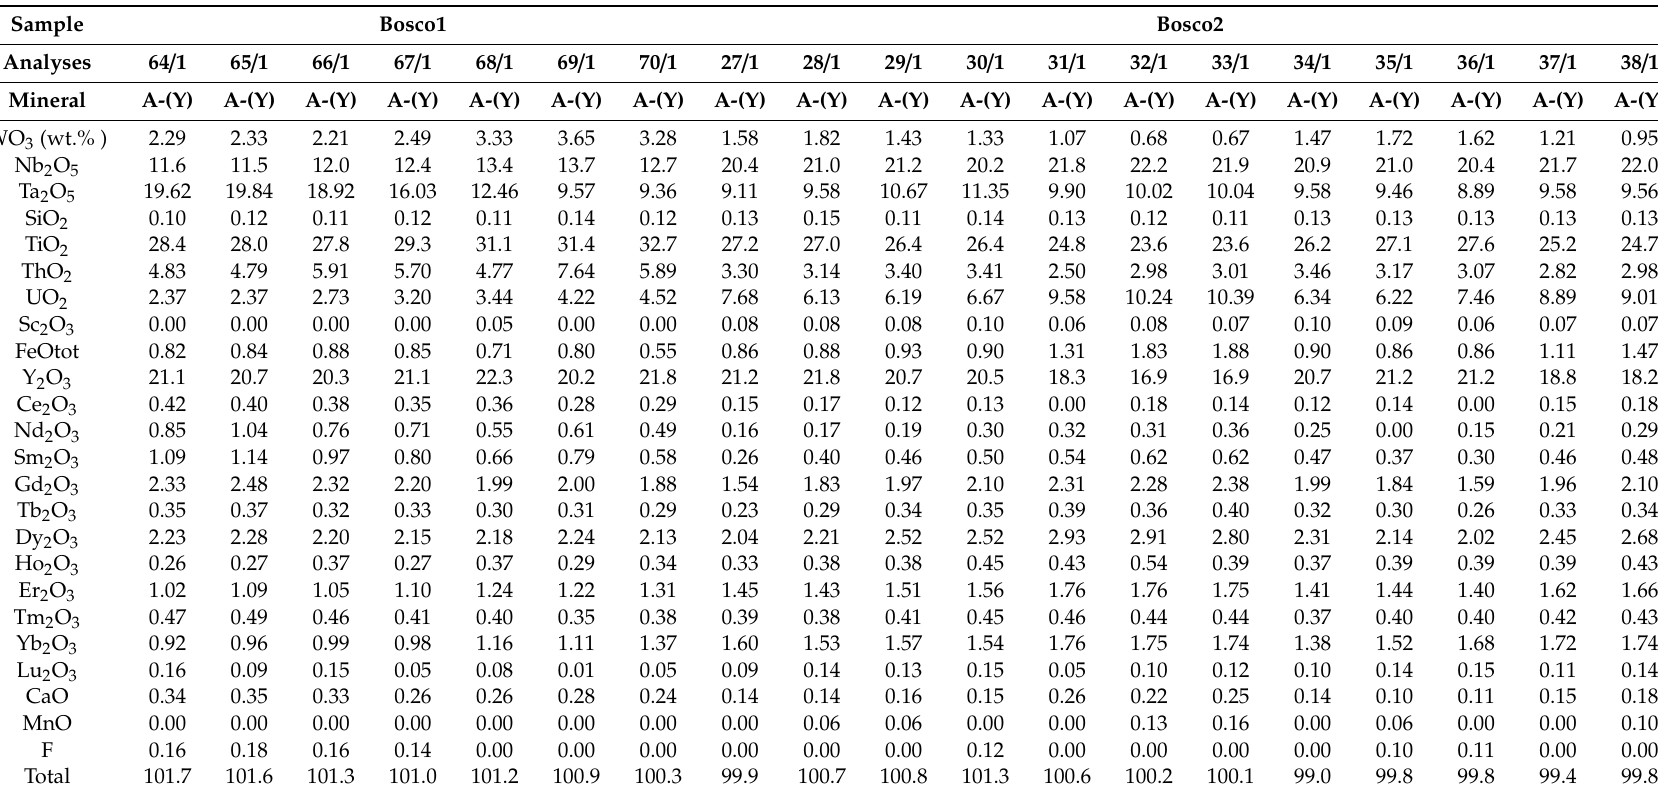
Table 1. Representative chemical compositions (in wt.% ) and mineral formulae (in apfu) of aeschynite-(Y) and polycrase-(Y) from Bosco and Fiume pegmatites at Arvogno.